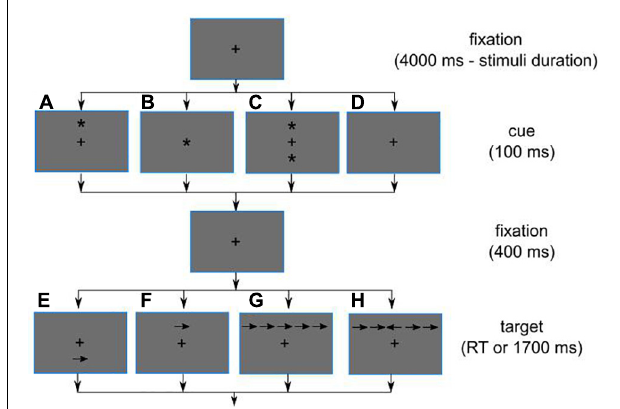
FIGURE 2 | The schematic diagram of trial sequence in Attention Network Task (ANT). The fixation is followed by the cue that primes one of two peripheral location (A) , central location (B) , both peripheral locations (C) , or no location (D) . The interim fixation is followed by single (D,E) or flankered target (F,H) . The cue (A) provides orientation cueing, the cues (B,C) increase alertness. The target can be incongruent (D) or congruent (E–H) in respect to the orientation cue (A) . The target (G) provides no-conflict (congruent) condition, while the target (H) embeds a conflict in arrow orientation. Note that some slide deducible configurations are not shown, i.e., orienting cue as well as flankered targets can be positioned at both spatial